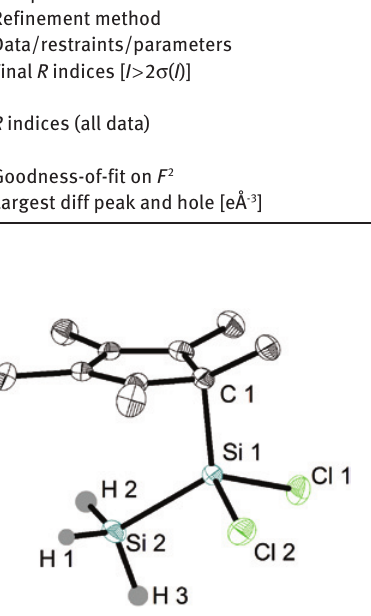
Figure 1: ORTEP diagram at 50% probability (Si, Cl, and C) and 20% probability (H) and atom numbering scheme for compound 1 . Hydrogen atoms at carbon atoms are omitted for clarity. Selected